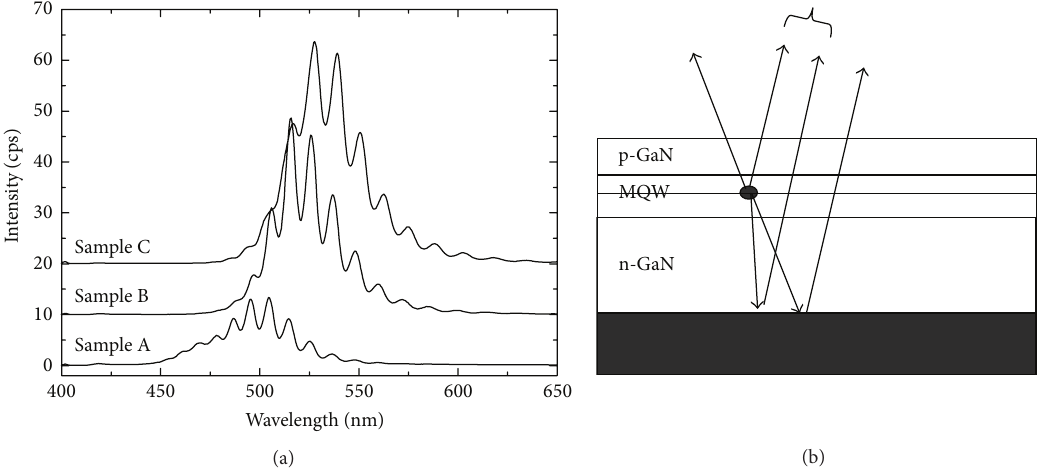
Figure 4: (a) PL spectra of the three samples are excitated by He-Ge 325 nm laser at room temperature. (b) Schematic diagram of optical cavity effects of the MQWs light from the surface and GaN/Si interface